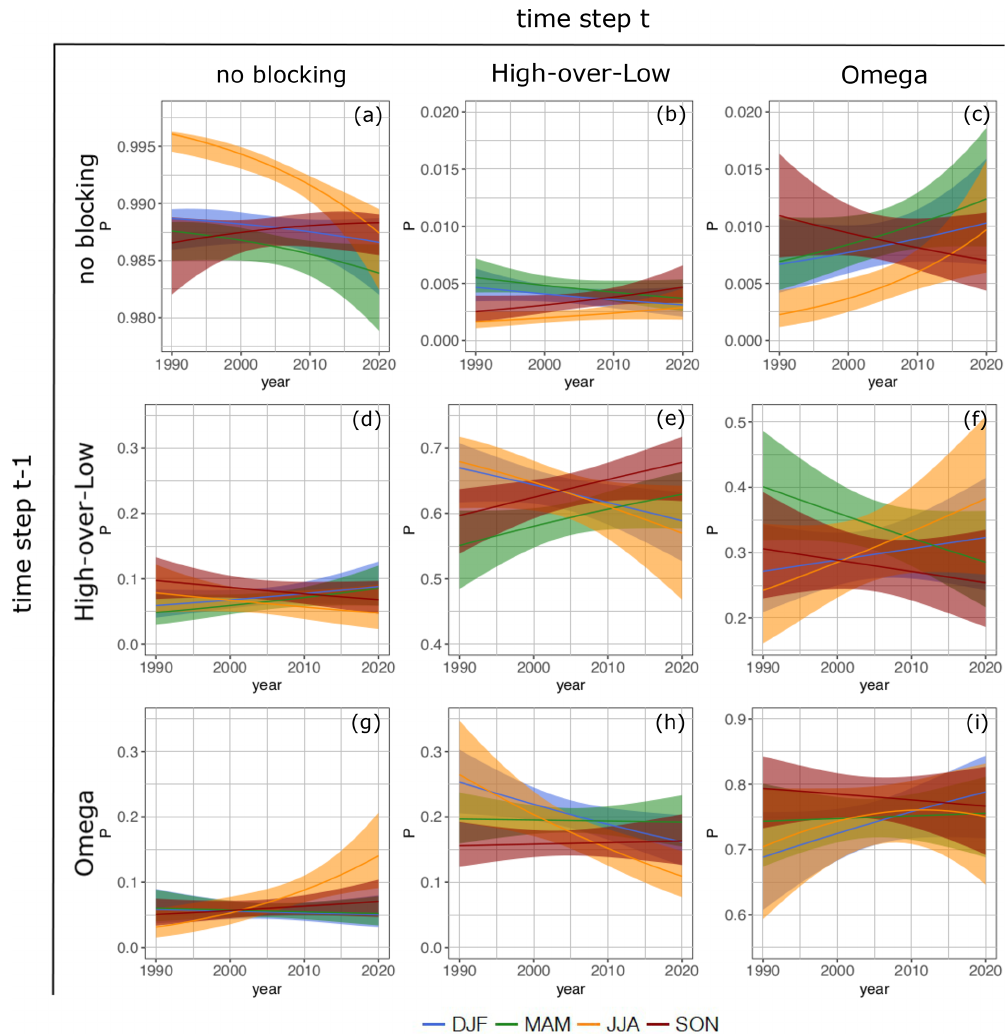
Figure 14. Transition probabilities analogous to the matrix of a three-state Markov process (Eq. 18) as a function of years for individual seasons (Eqs. 20 and 21) in the Euro-Atlantic region (40 ◦ W–30 ◦ E). Panels are ordered analogously to Fig. 13; season is color-coded. Shading shows 95% confidence